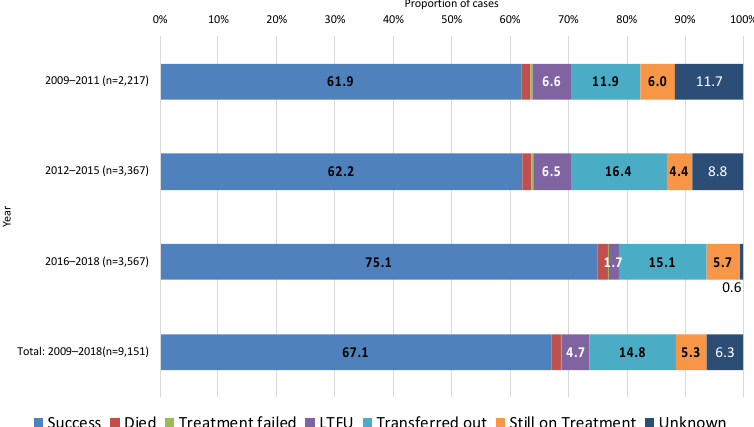
Figure 3. Treatment outcome of overseas-born patients with pulmonary tuberculosis in 2009–2018, and by the three periods. Abbreviations: LTFU, Lost to follow-up. Notes: Success includes “cure”, and “completed”.